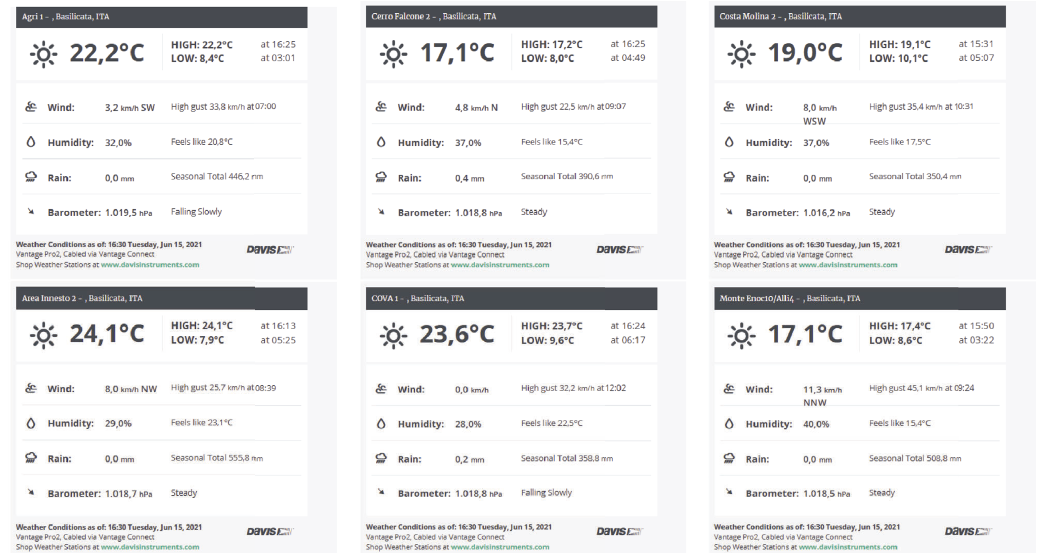
Figure 5: An overview of the real time monitoring control for the six weather stations in the Val d’Agri catchment. SCATTER PLOT TEMPERATURE, KALM-HD 1.25 km